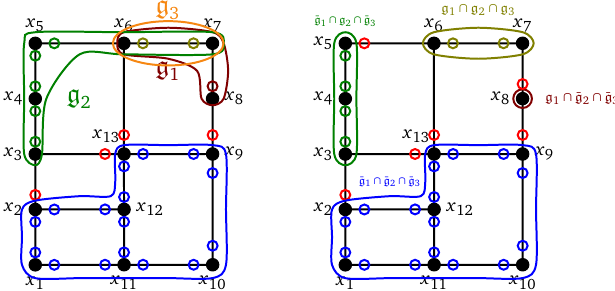
Figure 6: The intersection of the three facets identified by the subgraphs g g on the scattering facet S 3